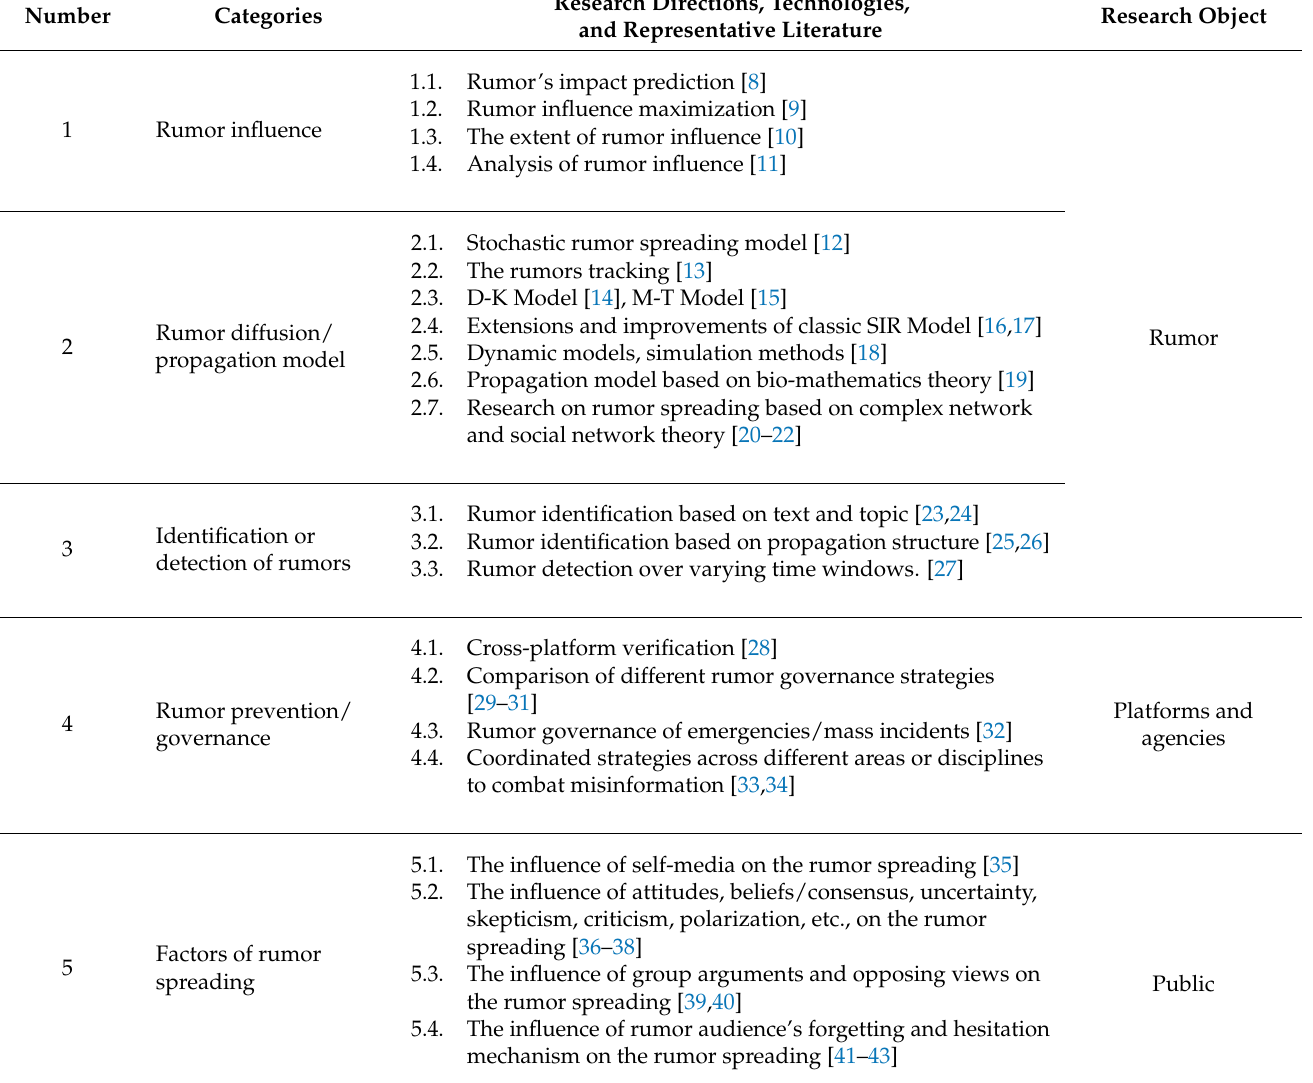
Table 1. Research of rumor classification and